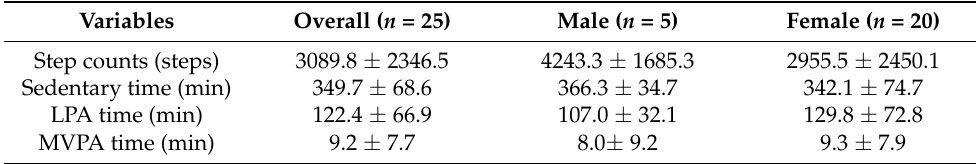
Table 4. Physical activity levels of the participants measured from 09:00 to